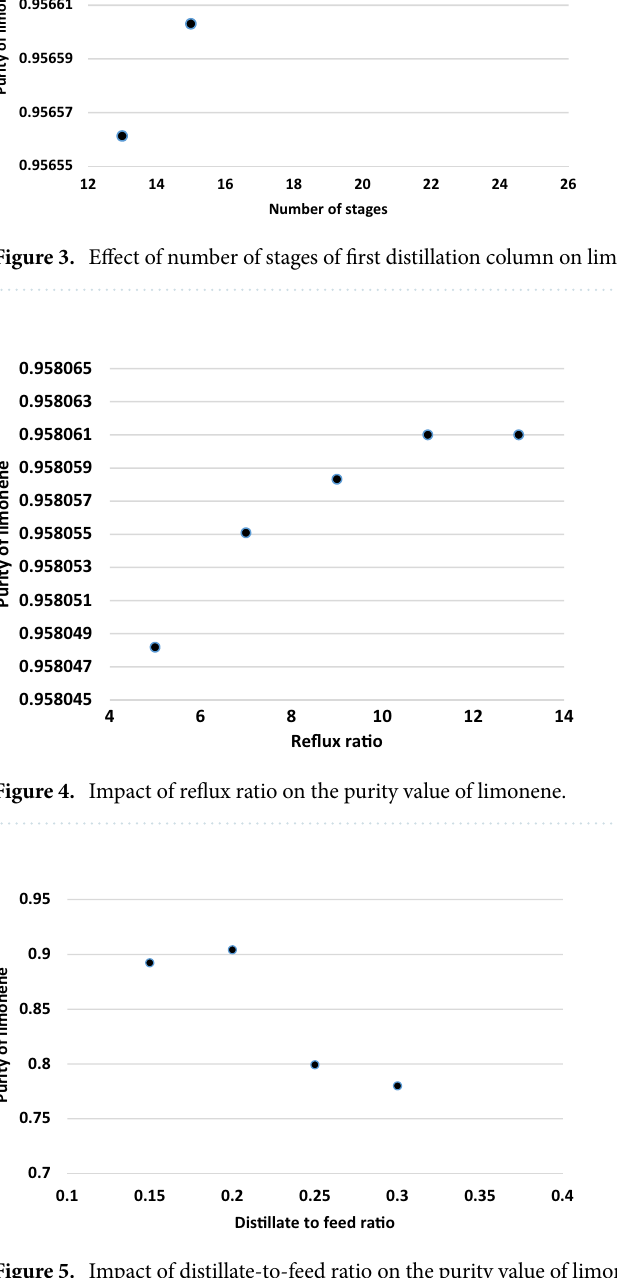
Figure 5. Impact of distillate-to-feed ratio on the purity value of